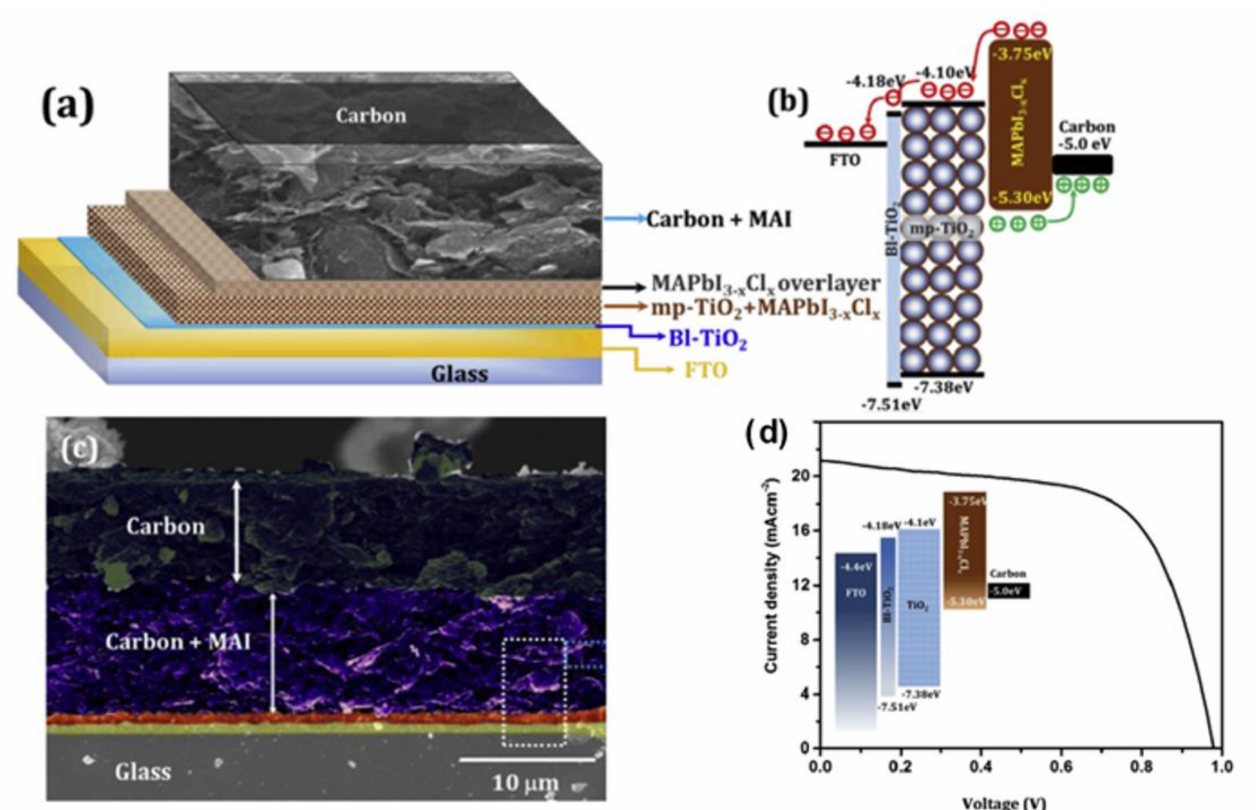
Figure 5. ( a ) A schematic image of the device configuration of a perovskite solar cell made of carbon electrode on a glass substrate. ( b–d ) Energy level diagram, a cross-sectional SEM image, and J-V characteristic curve of the device, respectively. Modified and reprinted from Sawanta S. Mali et al., (2017), [70] Copyright (2017), with permission from Elsevier.